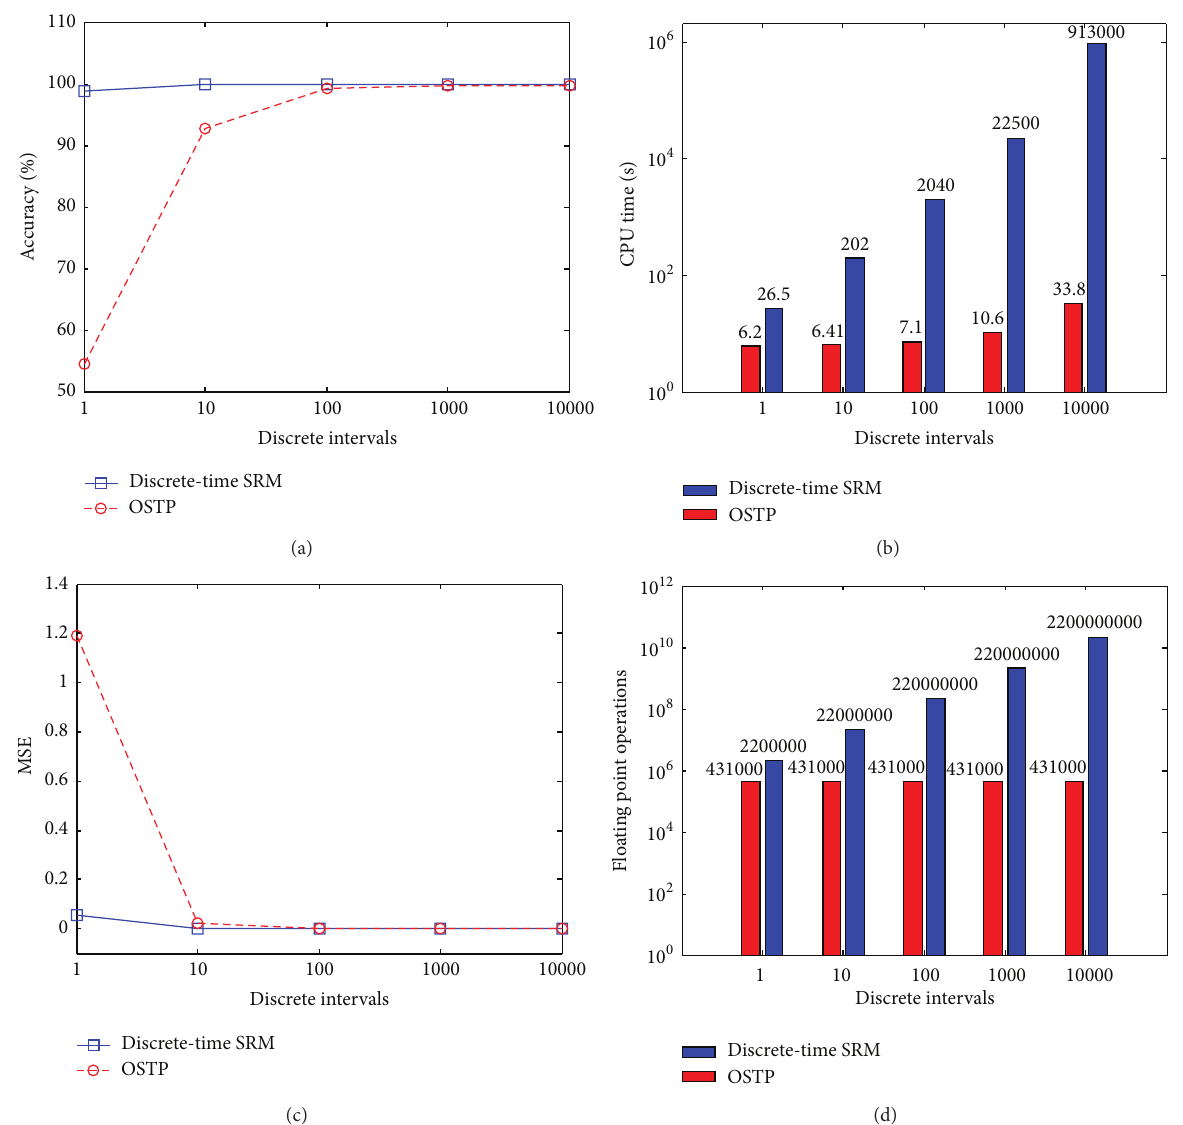
Figure 10: Comparisons on the (a) accuracy, (b) processing speed, (c) MSE, and (d) number of floating points operations of OSTP and discrete-time SRM for different values of 𝜎